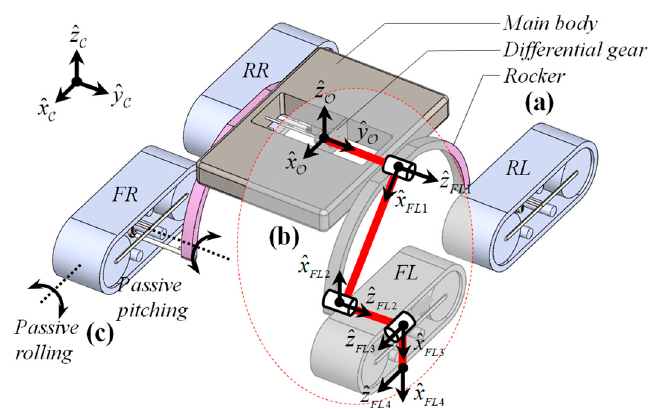
Figure 1. Proposed quad-tracked MR: ( a ) four driving tracks connected with main body with rocker, ( b ) joint coordinate frames assigned to the front left suspension as an example of suspension kine- matics, ( c ) 2-dof pitch-roll joints for passively connecting rockers and driving tracks.